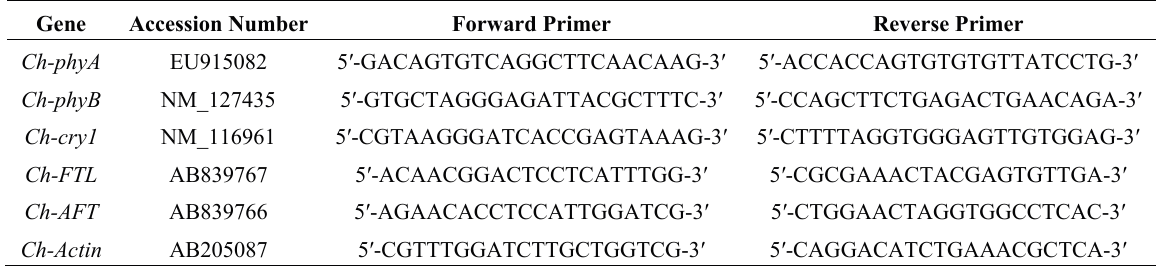
Table 2. List of primers used to quantify gene expression